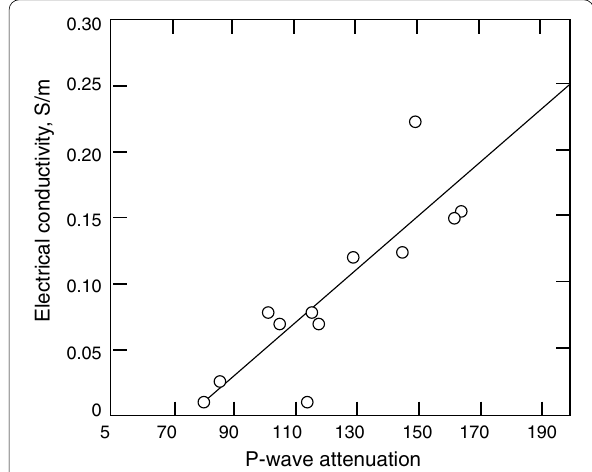
Fig. 40 Chlorine diffusion in quartz-H 2 O as a function of total fluid concentration. Modified from Brenan (1993)